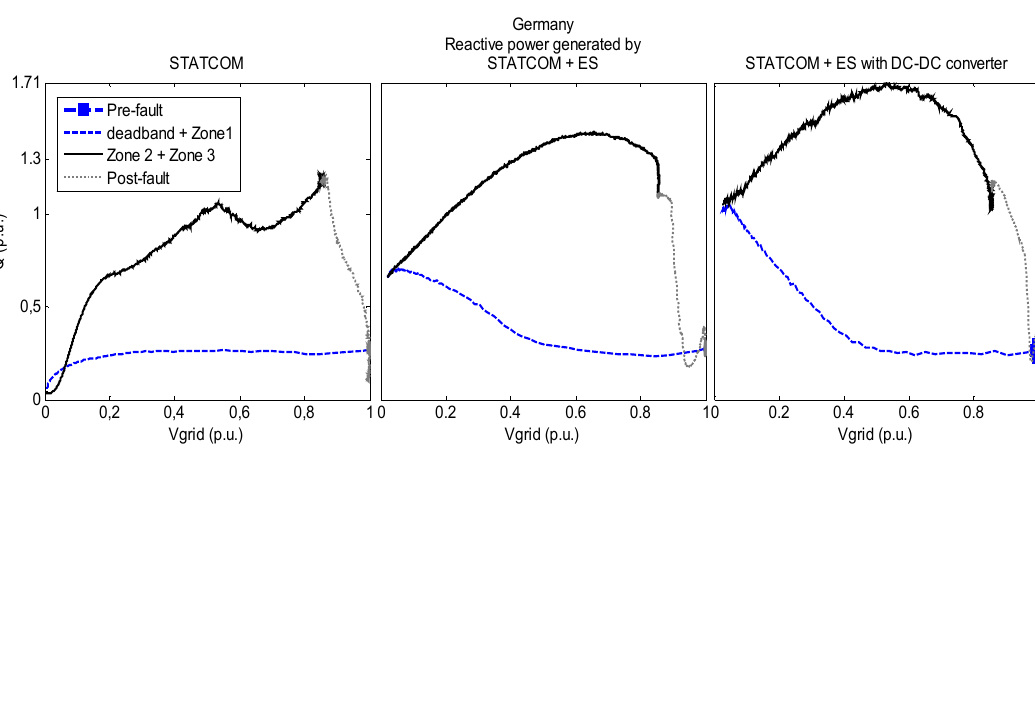
Figure 19. STATCOM reactive power evolution through the voltage dip, German